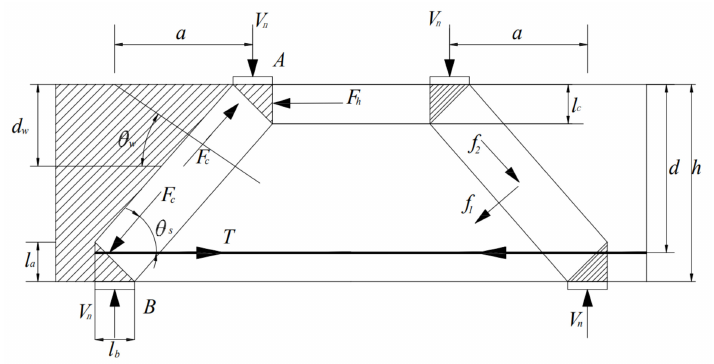
Figure 17. Strut-and-tie model for deep beams.